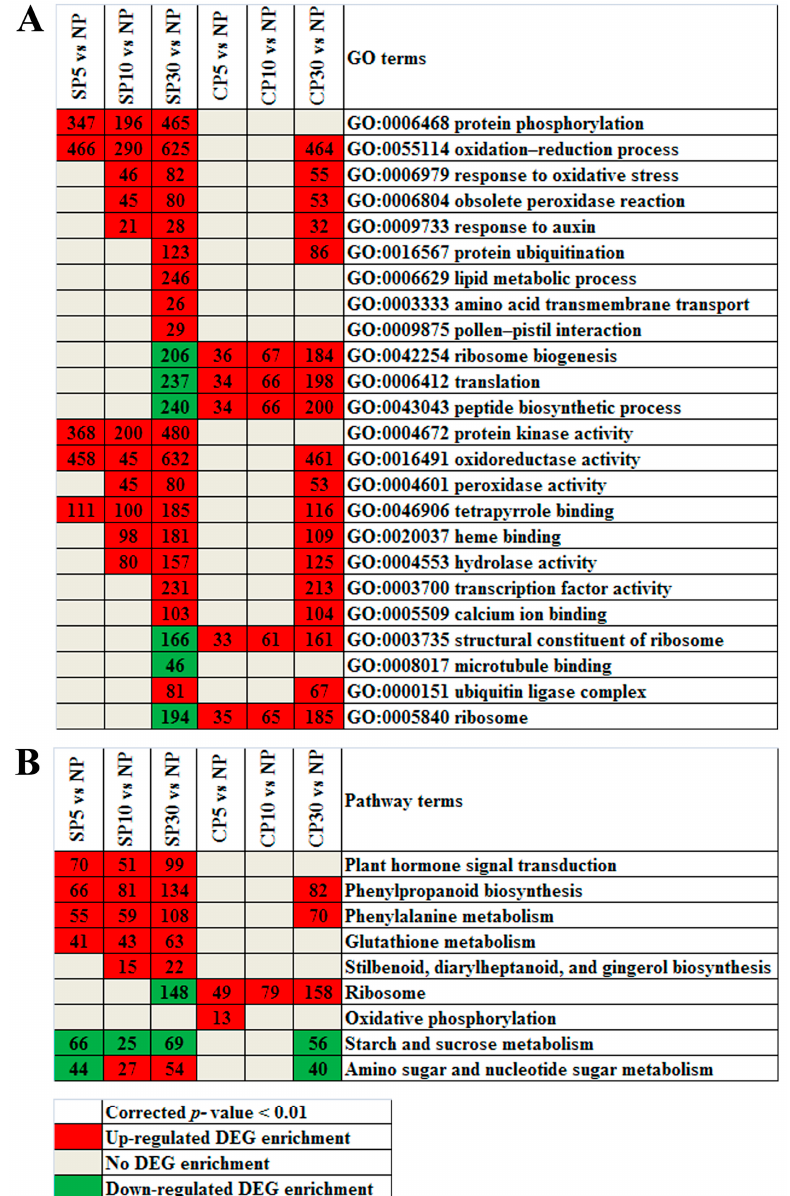
Figure 6. Enriched GO terms and KEGG pathways of the differentially expressed genes (DEGs). ( A ) Enriched GO terms of the DEGs. ( B ) Enriched KEGG pathways of the DEGs. GO terms and KEGG pathways with corrected p -value < 0.01 were considered significantly enriched. Red, upregulated DEG enrichment; green, downregulated DEG enrichment; and gray, no DEG enrichment. SP5, SP10, and SP30 indicate DEGs in self-pollinated pistils compared to nonpollinated pistils at 5 min, 10 min, and 30 min, respectively. Similarly, CP5, CP10, and CP30 indicate DEGs in cross-pollinated pistils compared to nonpollinated pistils at 5 min, 10 min, and 30 min, respectively.